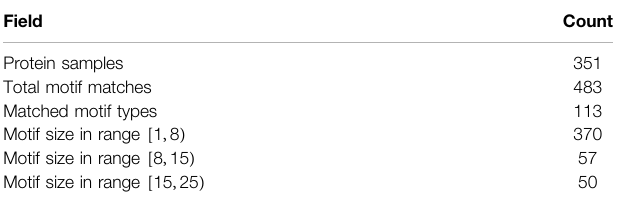
TABLE 4 | Statistical data of matched motifs in case